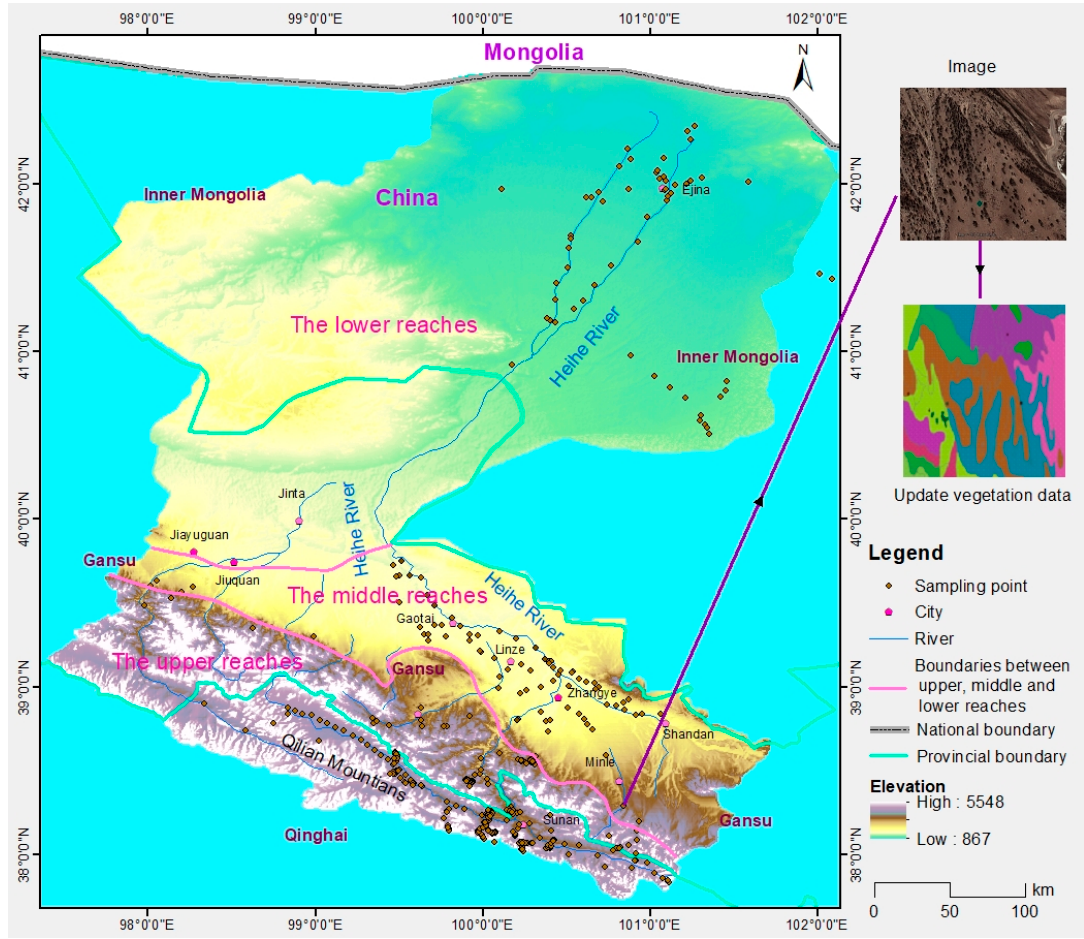
Figure 1. Field samples, DEM, and boundary of Heihe River Basin. The vegetation types of temperate small scrubs and semi-scrub deserts are mainly located in the middle and lower reaches of Heihe River Basin, where the elevation is generally less than 2000 m. In addition to a few of the desert vegetations of natural small- scrubs and semi-scrubs, the middle reaches are mainly covered by a large number of cultivated crops and planted forests. The lower delta of Heihe River basin is dominated by desert vegetations such as Populus euphratica , Haloxylon ammodendron , Elaeagnus angustifolia , Tamarix chinensis , and Nitraria tangutorum , among others [21,22]. In general, the distribution of Heihe Rivere Basin vegetation shows an obvious vertical zonality. The richness of vegetation types distributed in Qilian Mountains, Ober Beach, and Yeniugou Basin in the upper reaches is higher than that in other areas. The semi-scrub/dwarf semi-scrub desert, scrub desert, Kobresia/weed alpine meadow, and cultivated vegetation are the major vegetation types, covering 74.00% of the whole Heihe River Basin, in which the area of semi-scrub/dwarf semi-scrub desert is up to 57,222.87 km 2 , accounting for 44.53% of the total